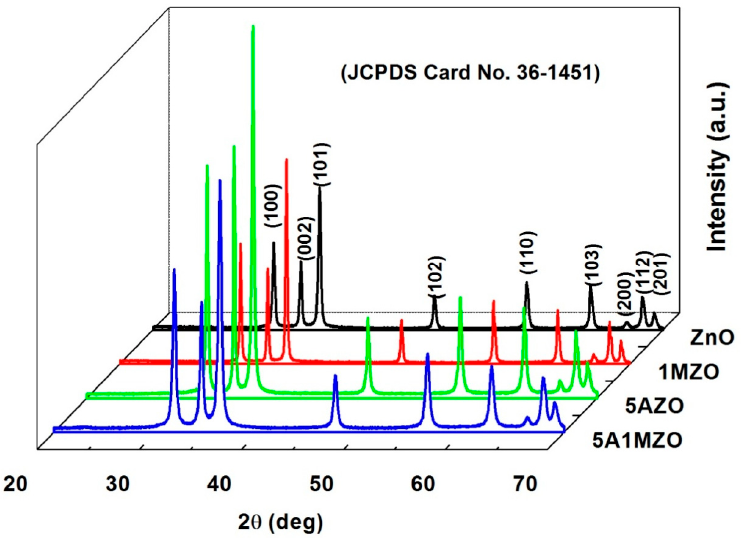
Figure 2. XRD diffractograms of ZnO, 1MZO, 5AZO and 5A1MZO samples.